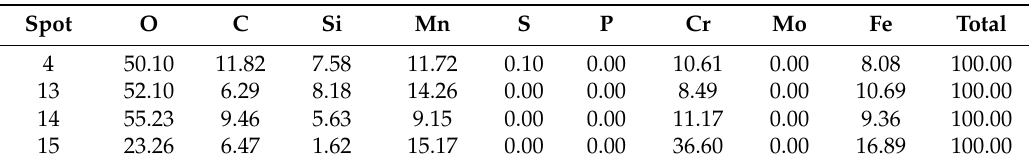
Table 5. Elemental composition distribution of the oxide particles from EDS analyses on the corresponding spots marked in Figures 8b and 9b (at